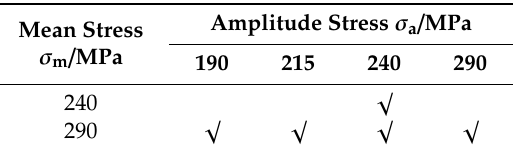
Table 2. Ratcheting experiments scheme.